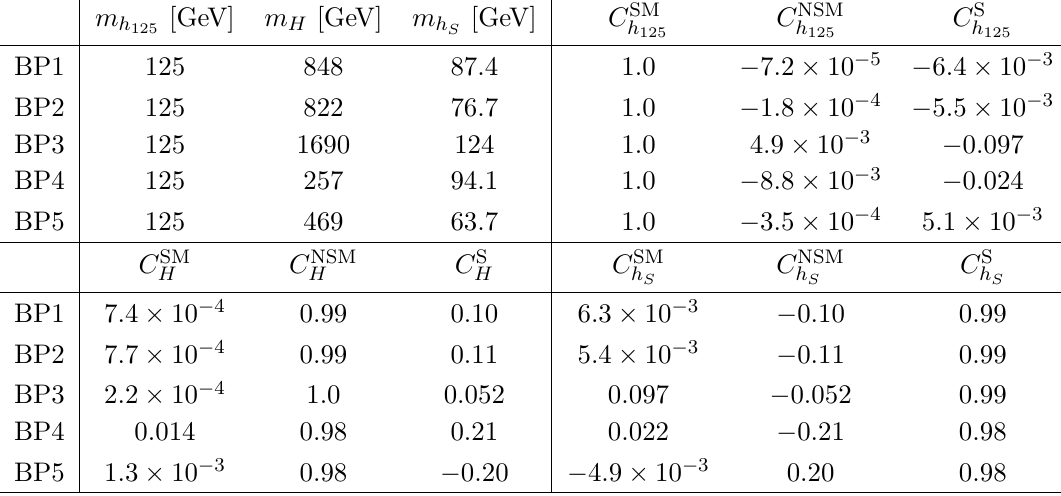
Table 2 . Physical masses of the CP-even Higgs bosons and composition in terms of the interaction states of the extended Higgs basis for our benchmark